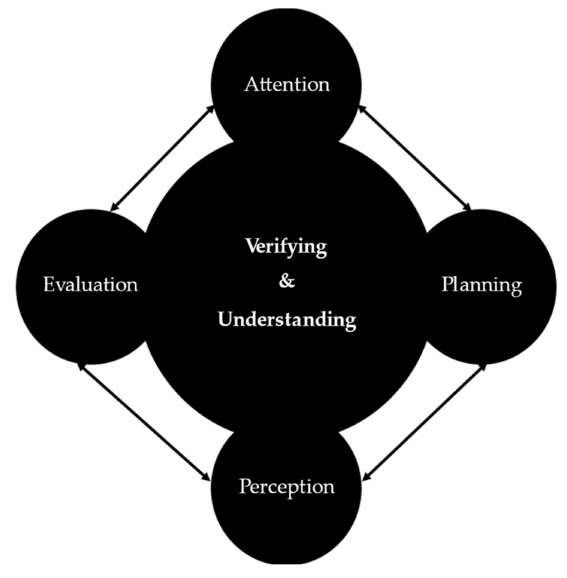
Figure 6. Basic CDI